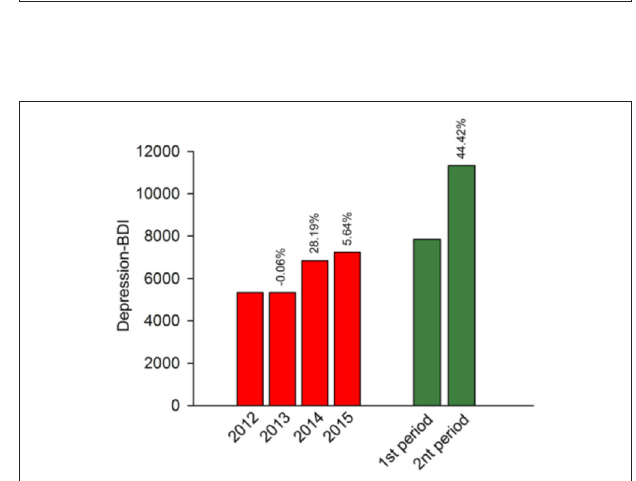
FIGURE 2 | Index for Depression-BDI, depression-SMI, Suicide-BDI, Schizophrenia-BDI, Obsessive compulsive disorder-BDI, Common cold-BDI, Stomach cancer-BDI, Liver cancer-BDI: 2015.09-2017.09. Marked date 16 September 2016: the suicide time of Qiao, 17 September 2016: Qiao’s agent announced that he had died by suicide because he could not afford to suffer from depression.